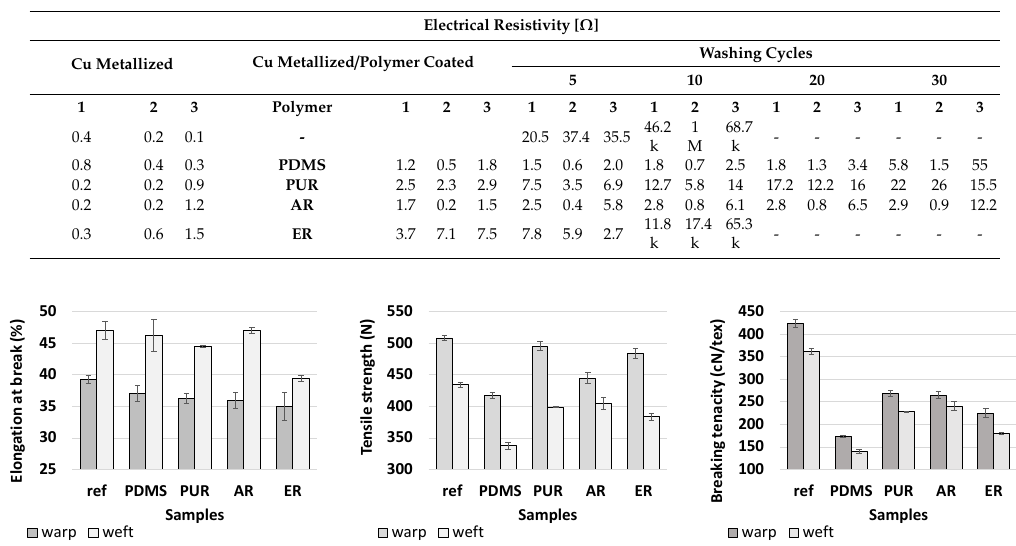
Figure 3. Mechanical features of uncoated and coated samples in warp and weft directions.